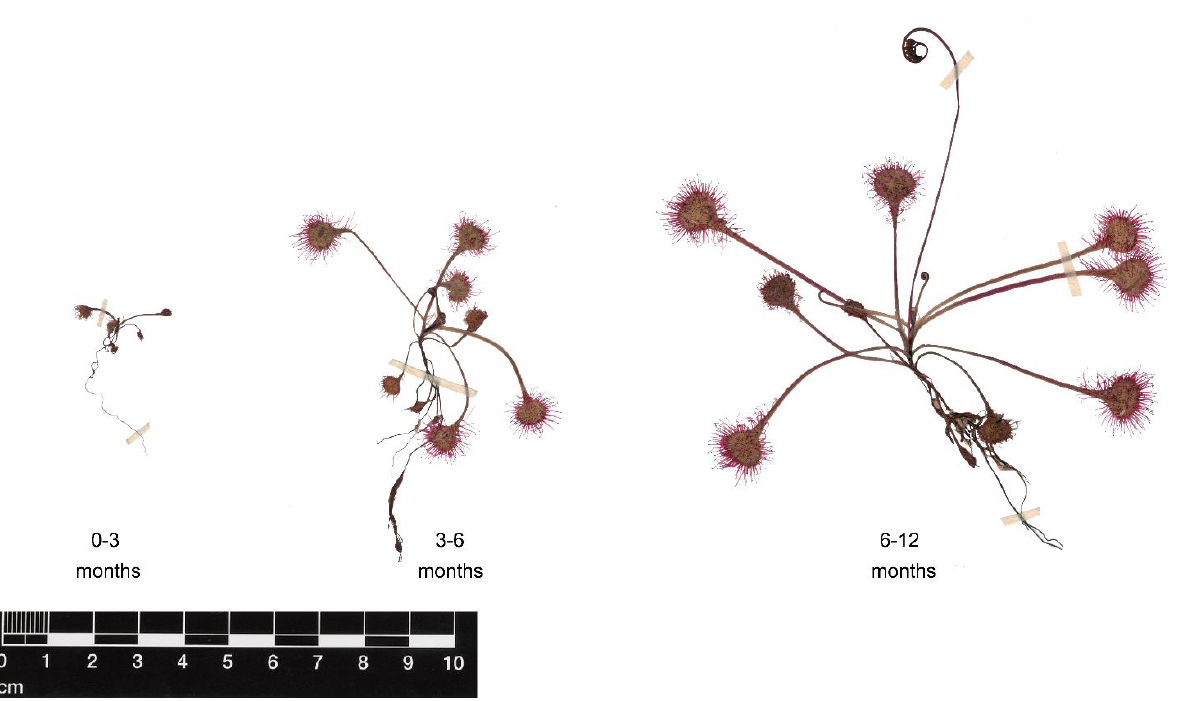
Figure A2. Drosera rotundifolia plants by age class, collected on the Sphagnum palustre field of the Sphagnum farm in Rastede (north-west Germany). Collected and determined by Balázs Baranyai, 17 August